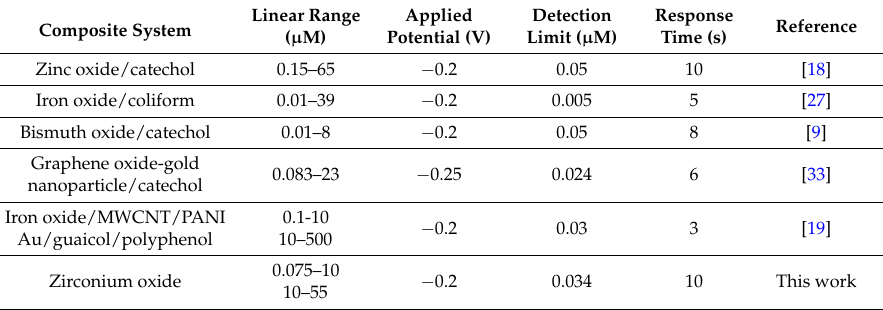
Table 2. Analytical characteristic of biosensors reported in literature for phenolic detection.